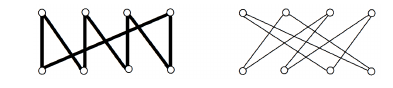
Figure 2: A red-blue coloring of K 4 , 4 in Example